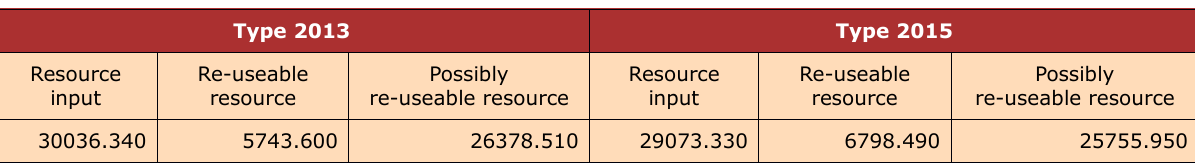
Table 2. Resource consumptions of each type